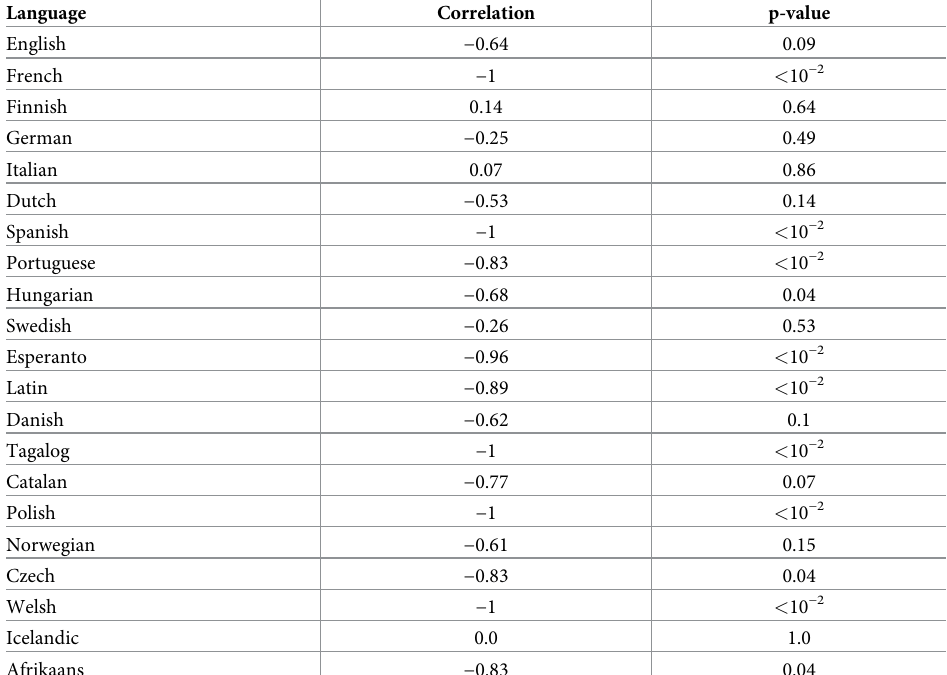
Table 3. Menzerath’s law tested on the 21 languages under study. Spearman’s rank correlation coefficients and p-val- ues between the size of the word and the mean size of the syllables. The regression function (4) for the memoryless source is monotonically decreasing so Spearman’s rank correlation coefficient equals − 1 in this